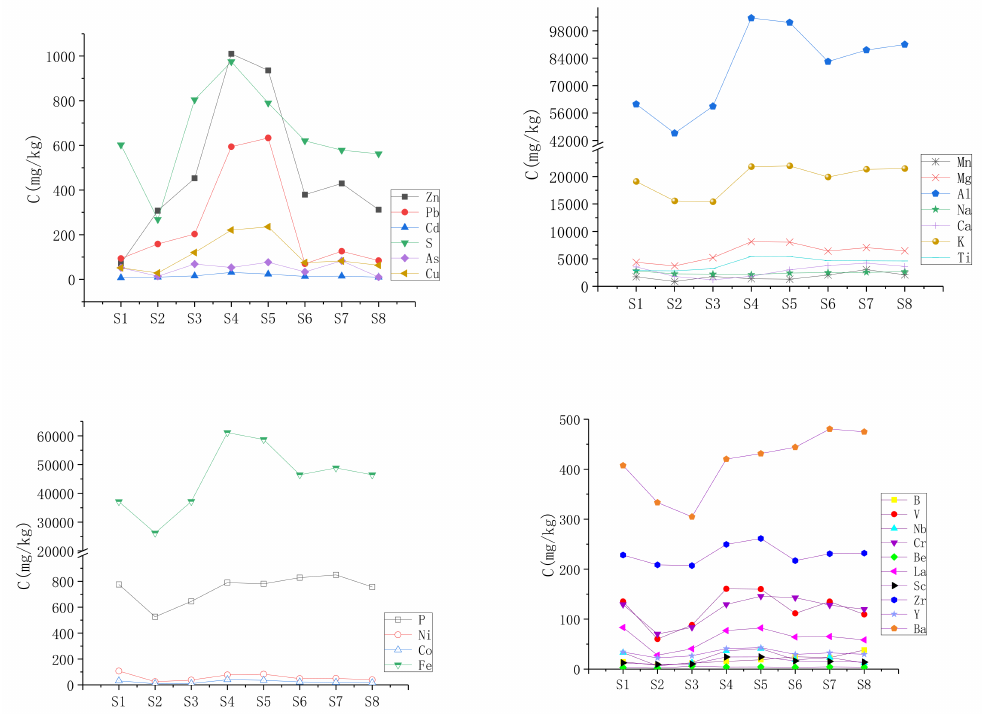
Figure 3. Distribution of elements in the study